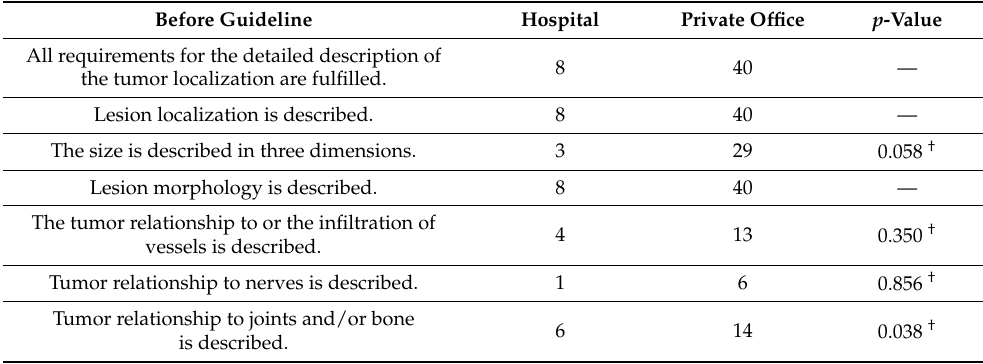
Table 6. Subgroup analysis of report criteria of the whole